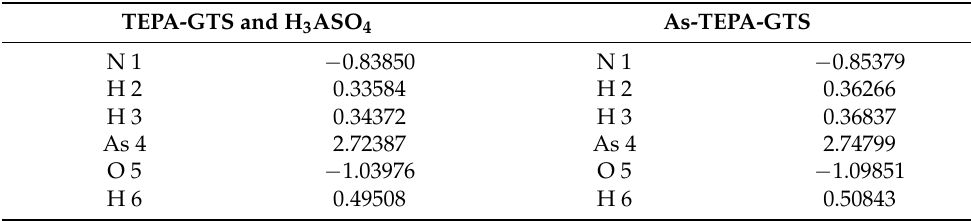
Table 6. NBO charge distribution of TEPA-GTS, H 3 AsO 4 and